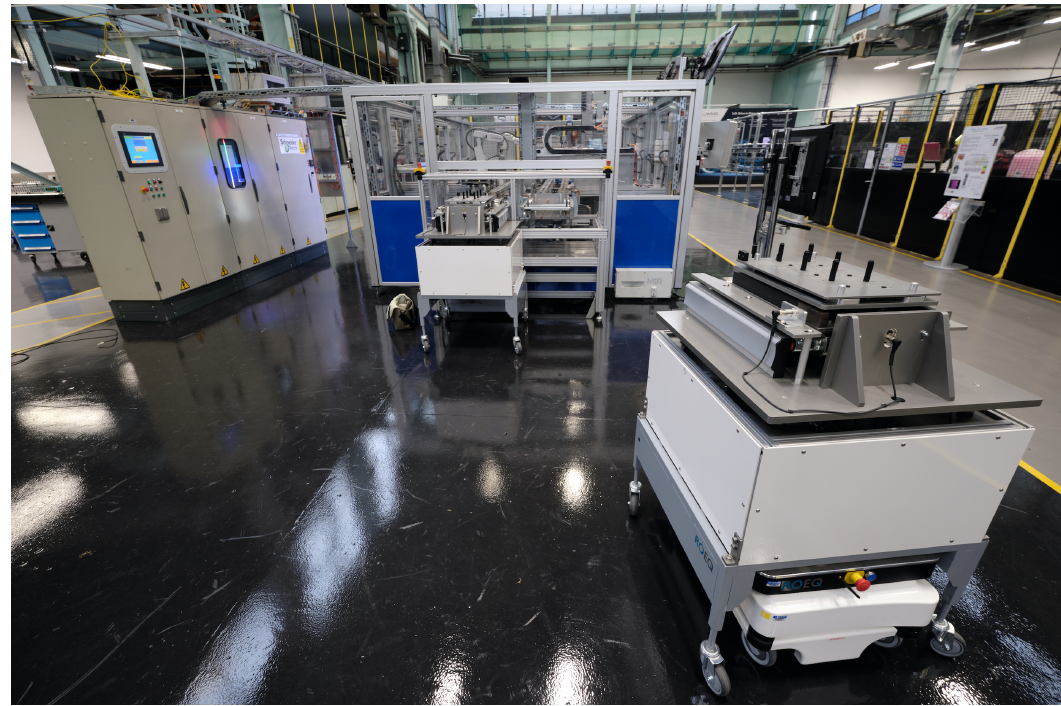
Figure 10. An example material transportation within the IML rig: An AGV is carrying battery cells to the Legacy Loop Assembly Machine in the Stage One where battery modules are